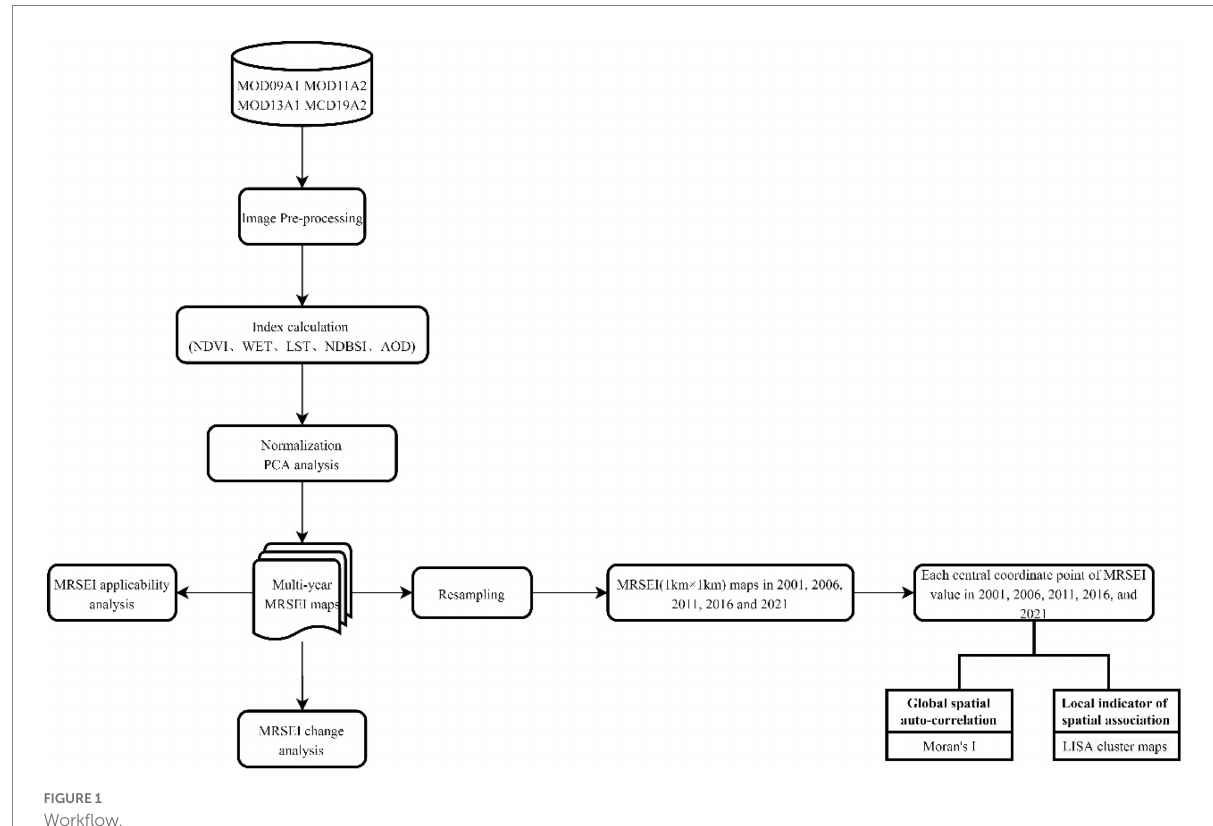
FIGURE 1 Workflow.